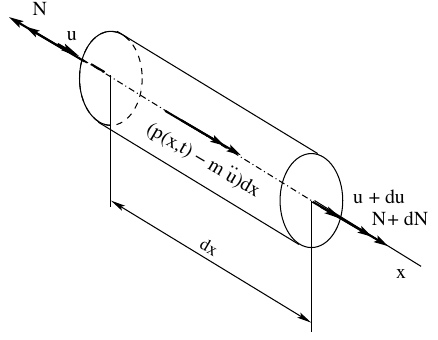
Fig. 1. Inertial force acting on a differential bar element.